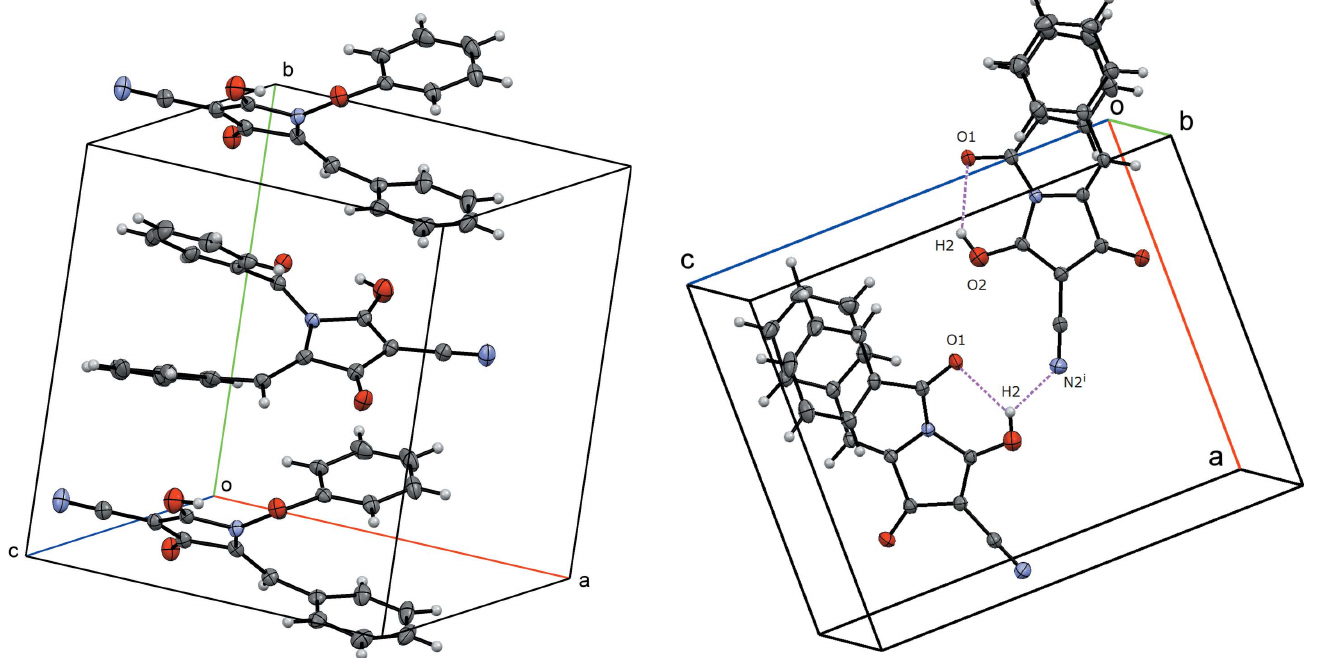
Figure 2 Arrangement of molecules along the b -axis direction.